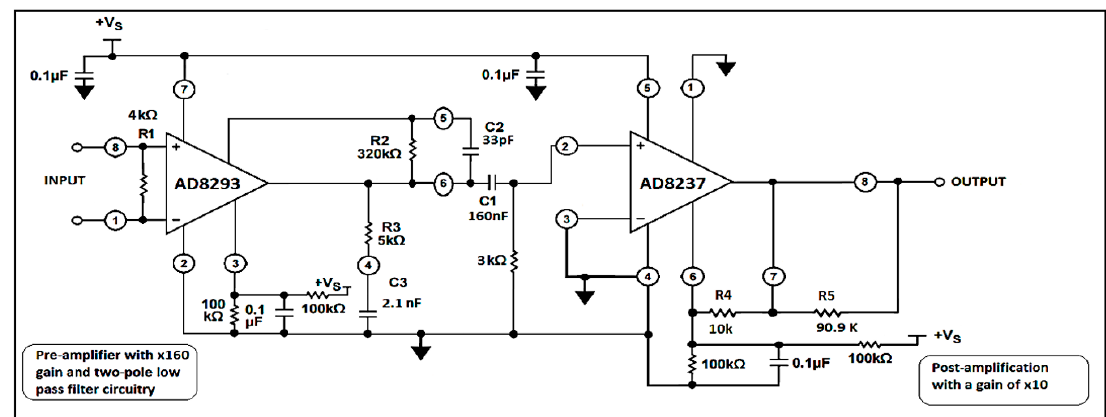
Figure 4. Schematic of the action potential detector.